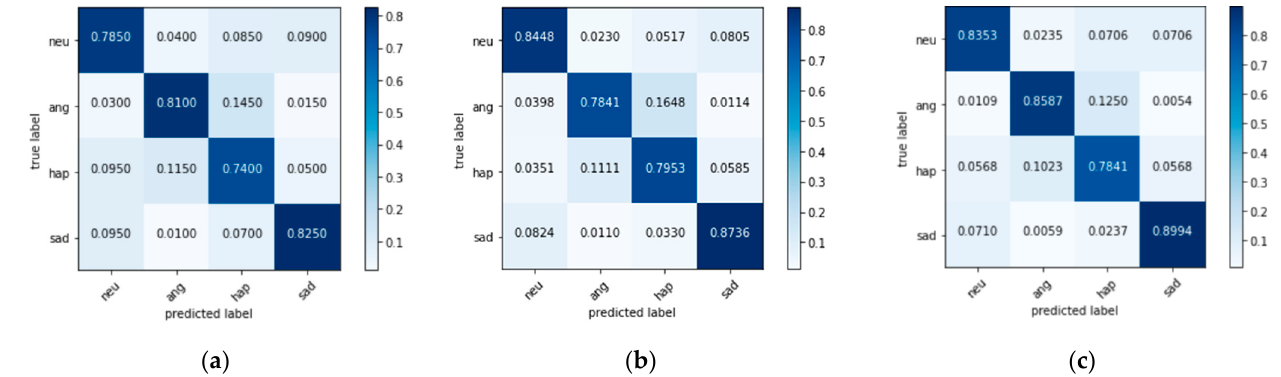
Figure 5. The confusion matrix of the CASIA corpus. ( a ) The confusion matrix for the MSFL_ST model. ( b ) The confusion matrix for the MTL_DNN model. ( c ) The confusion matrix for the MSFL model.